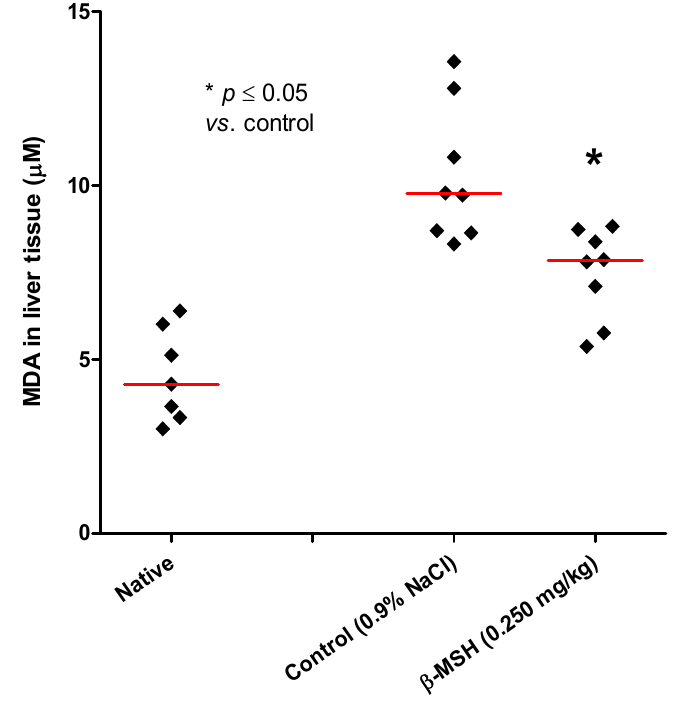
Figure 5. Level of liver tissue malondialdehyde (MDA) in native animals, control (0.9% NaCl) and β -MSH (0.250 mg/kg b.w.) treated groups. Diamonds represent individual values, and red lines denote median. p value is a result of comparison with the control group (Mann-Whitney